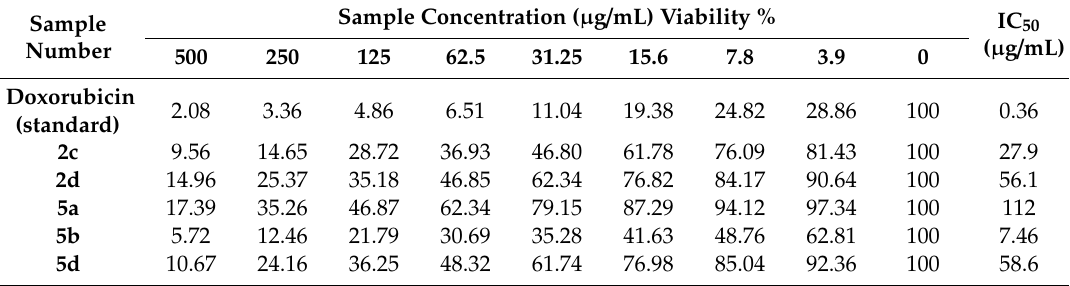
Table 5. Viability values and IC 50 of tested thiazolines and control drug Doxorubicin against hepatocellular carcinoma cell line (HepG-2) .